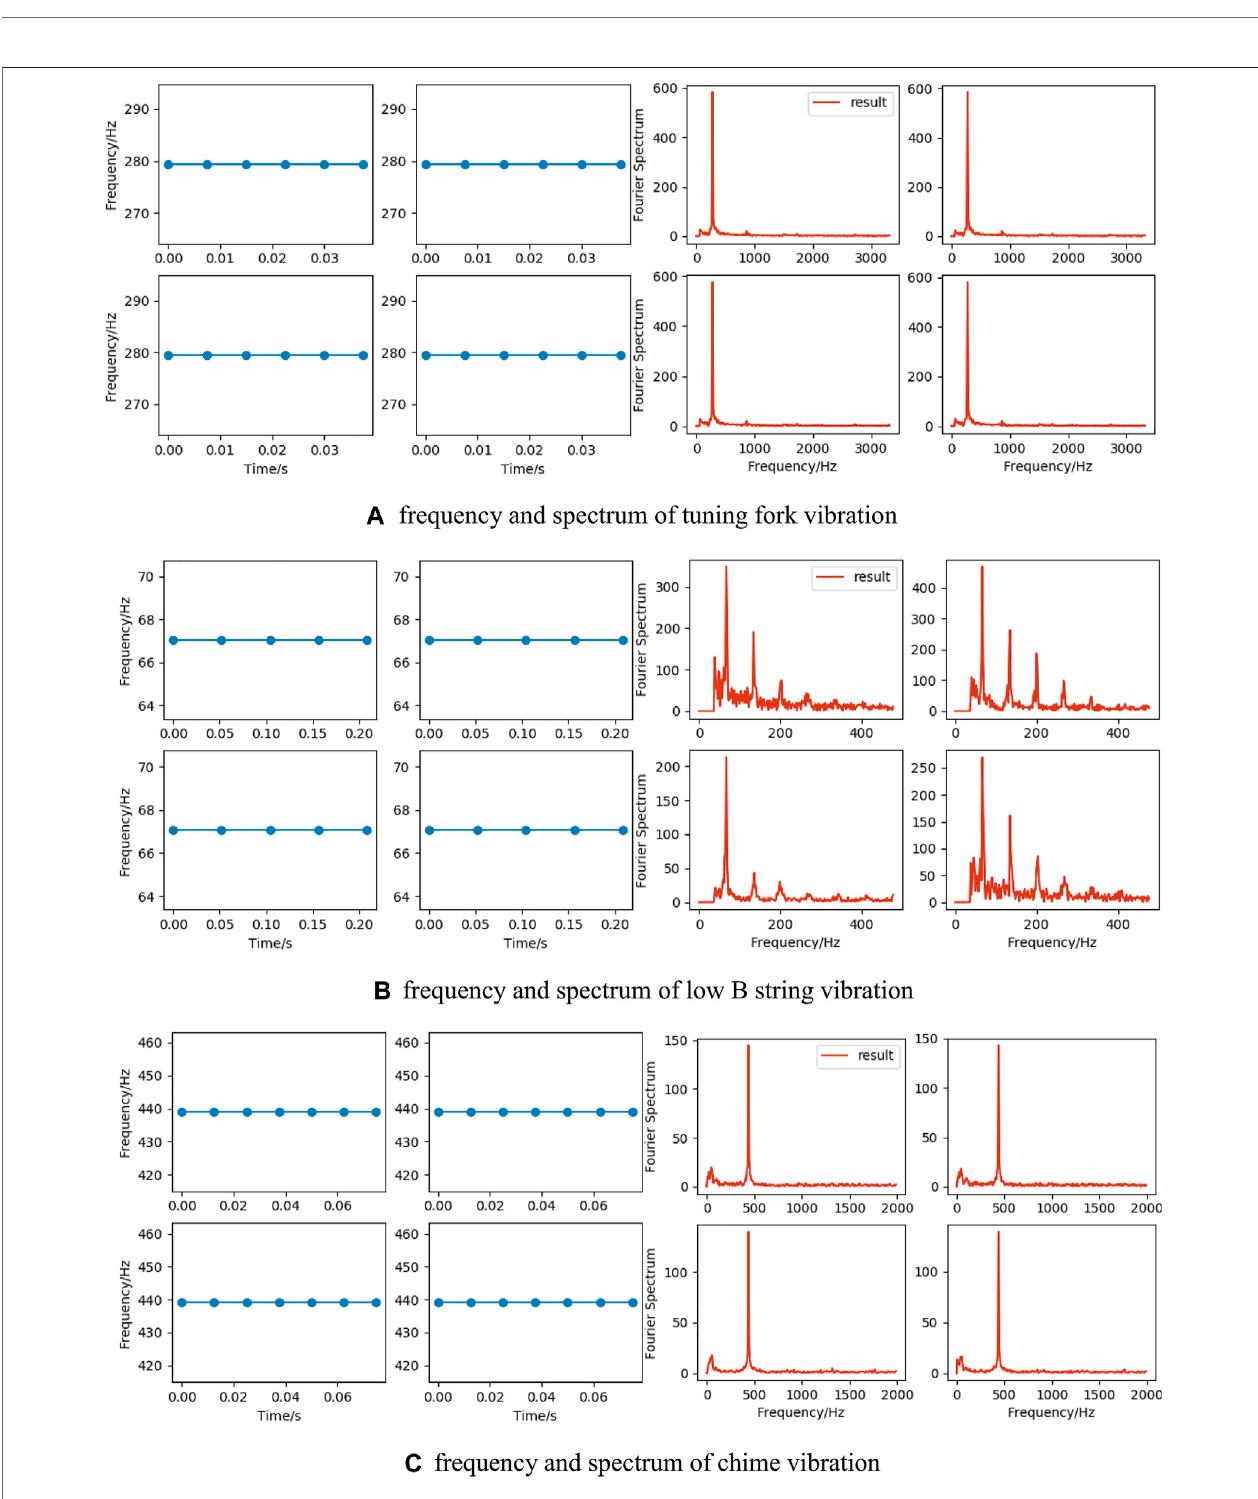
FIGURE 14 | (A – C) are frequencies and spectra calculated by taking the motion coordinate sequences of four feature points in Tuning Fork, Low B String, and Chime videos, respectively. (A) frequency and spectrum of tuning fork vibration. (B) frequency and spectrum of low B string vibration. (C) frequency and spectrum of chime